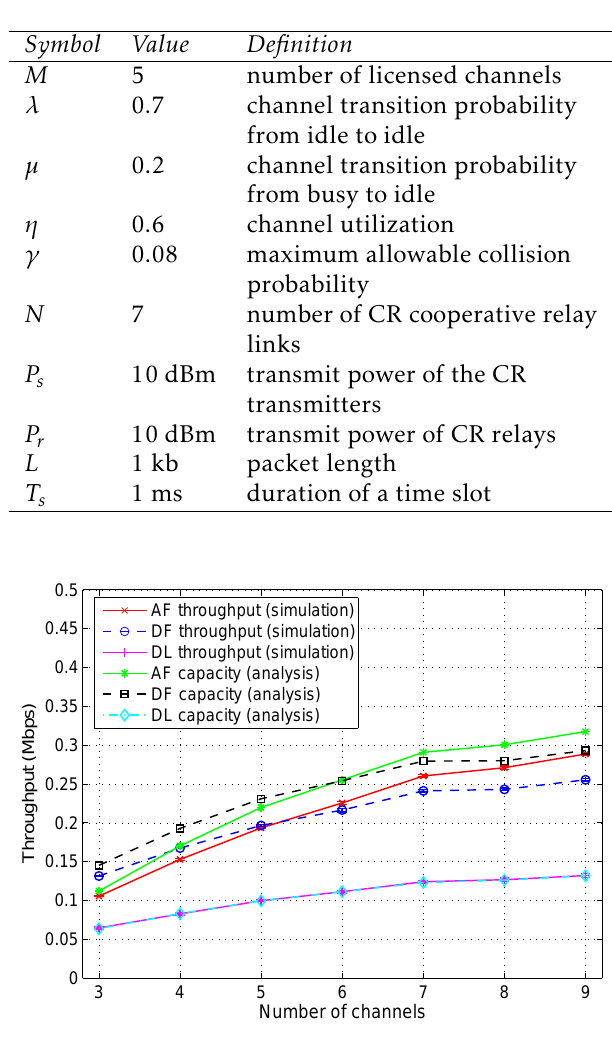
small. Furthermore, as the number of license channels is increased, the throughput of both AF and DF are increased. The slope of the AF curves is larger than that of the DF curves. There is a cross point between five and six, as predicted by both simulation and analysis curves. This indicates that AF outperforms DF when the number of channels is large. This is because AF is more flexible than DF in exploiting the idle channels in the two consecutive time slots. The DL analysis and simulation curves also increases with the number of channels, but with the lowest slope and the lowest throughput